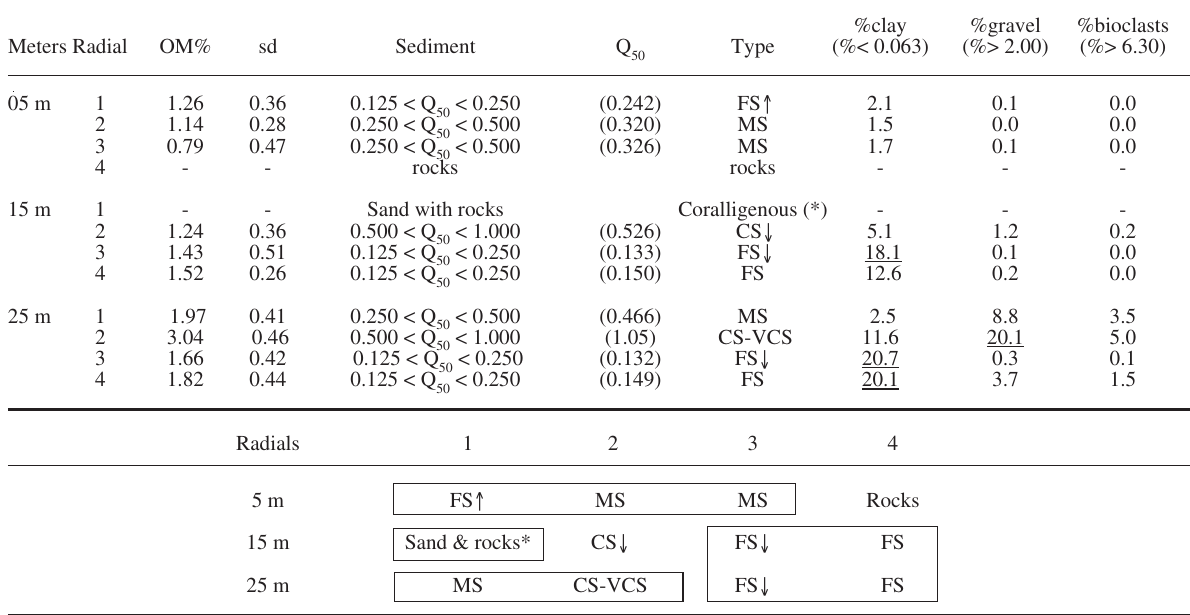
Table 2. – Results of the sediment analysis (according to sizes): <0.063 silts or mud (V), 0.063 - 0.125 very fine sand (VFS), 0.125 - 0.250 fine sand (FS), 0.250 - 0.500 medium sand (MS), 0.50 - 1.0 coarse sand (CS), 1.00 - 2.00 very coarse sand (VCS), >2.00 gravel (G) and organic material (OM%), by radial (R) and depth (D) in meters (sd: standard deviations). Q : mean particle diameter. In the inferior margin a sketch 50 of sediment distribution by sampling stations; the squares represent different decapod assemblages (*rocky outcrop on sandy bottoms with abundant bryozoans and gorgonian corals).